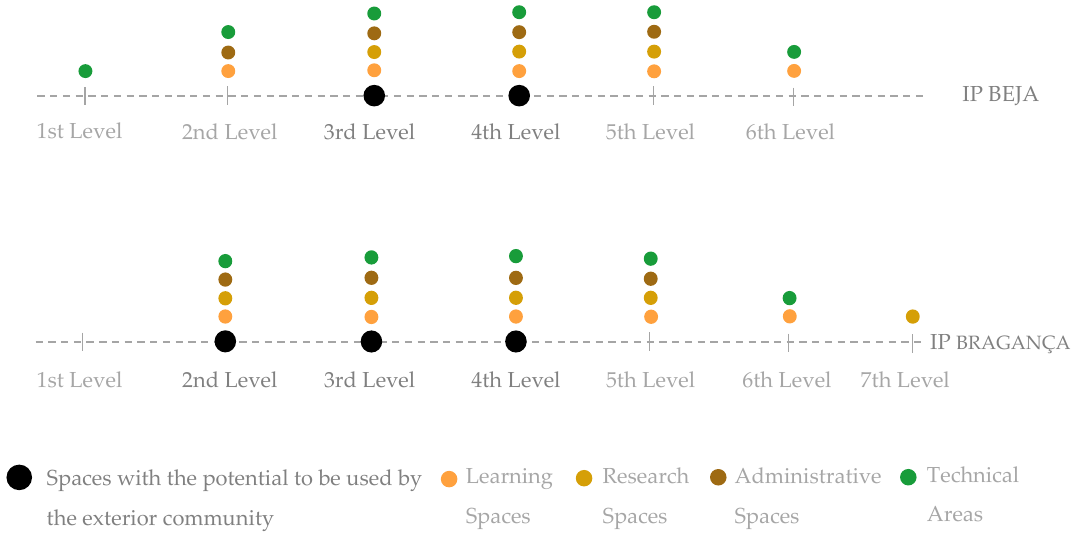
Figure 8. Functional analysis summary.